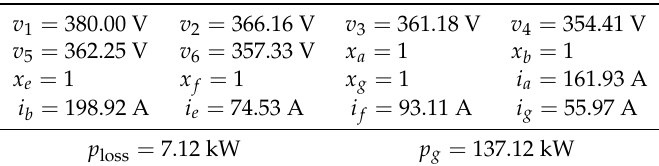
Table A3. Solution reached by general algebraic modelling system (GAMS) for the reconfiguration problem in the 6-nodes test